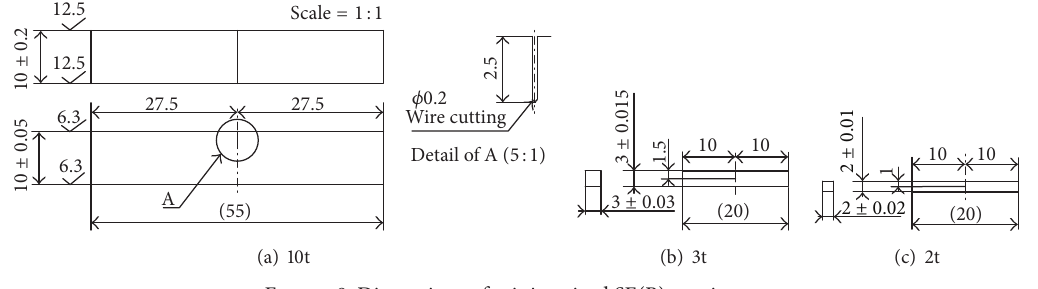
Figure 8: Dimensions of miniaturized SE(B)